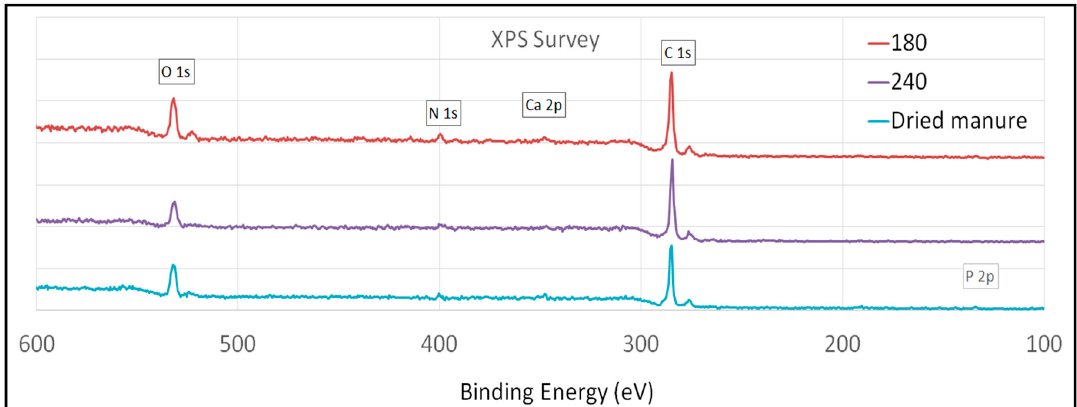
Figure 3. Representative X-ray photoelectron spectroscopy (XPS) plots of hydrochars and dried manure (×10 3 CPS vs. Binding Energy).